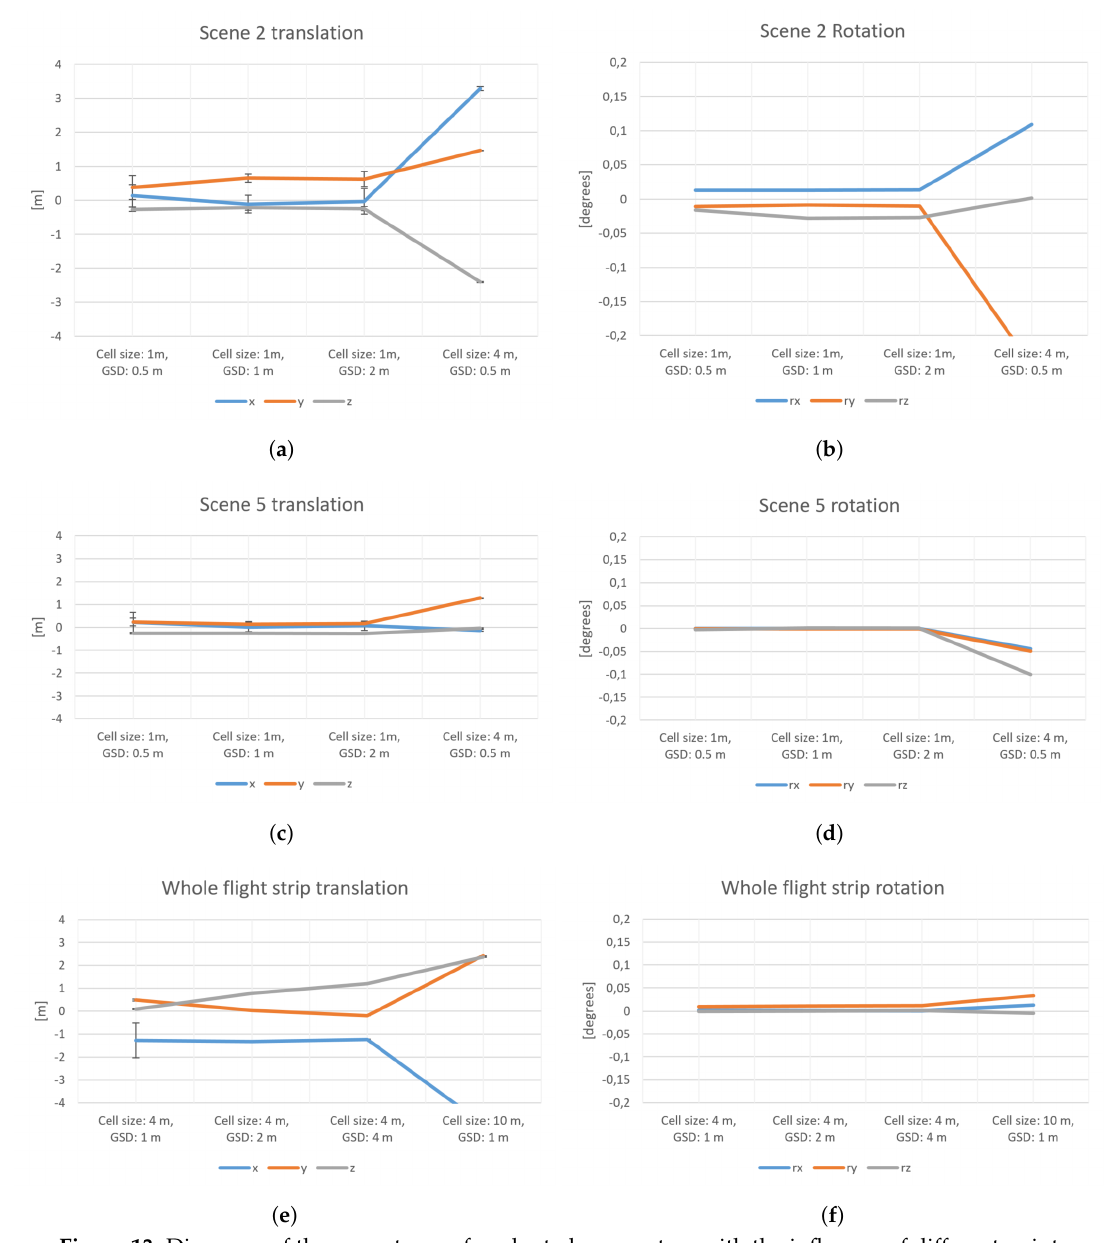
Figure 13. Diagrams of the correctness of evaluated parameters with the influence of different point distances. Shown are the scenes 2 ( a , b ), 5 ( c , d ) and for the whole flight strip ( e , f ) with the translation parameters on the left side and rotation parameters on the right